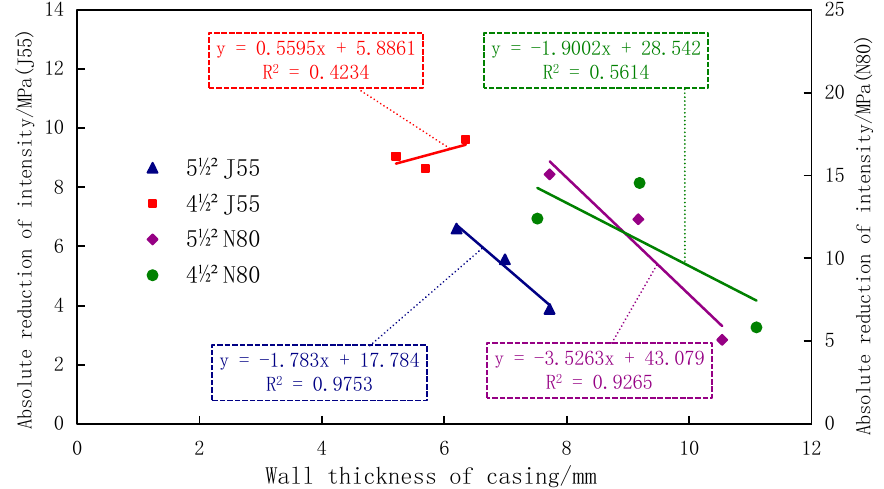
Energies 2019 , 12 , x FOR PEER REVIEW Figure 17. Relationship between absolute intensity-reduction value and casing wall thickness.